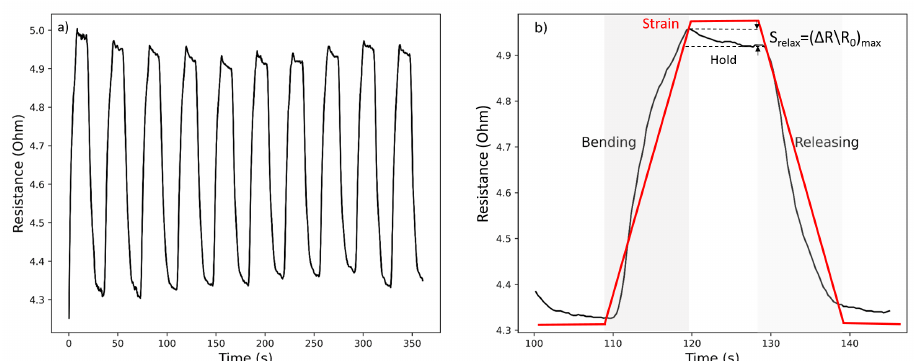
Figure 4. The cyclic hold test of knitted strain sensor: ( a ) Resistance versus time graph when the hold time was set as 10 s, and ( b ) Relaxation during the holding phase.